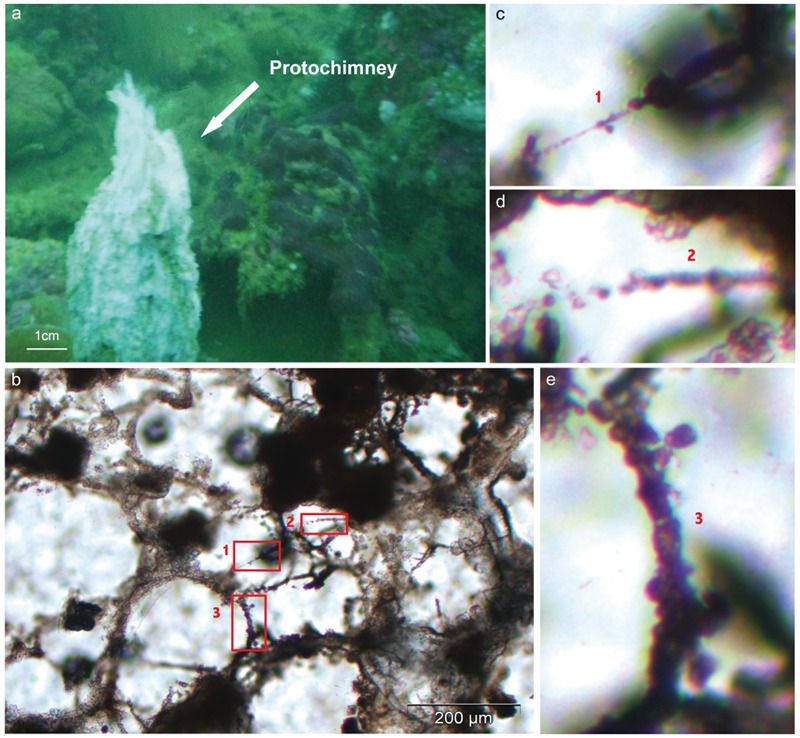
(a) Dive photograph of whitish centimetric protochimneys typifying nascent overgrowth on the top of active hydrothermal edifice at the location where the hydrothermal fluids actively discharge (Site ST12; modified from Quéméneur et al., 2014). (b–e) Optical views of a thin section obtained from resin embedded protochimneys and showing from the very first instants of the hydrothermal venting the presence of mineralizing filaments [progressive mineralization steps can be followed by the windows numbered from 1 to 3 in (b) and magnified in (c–e)].